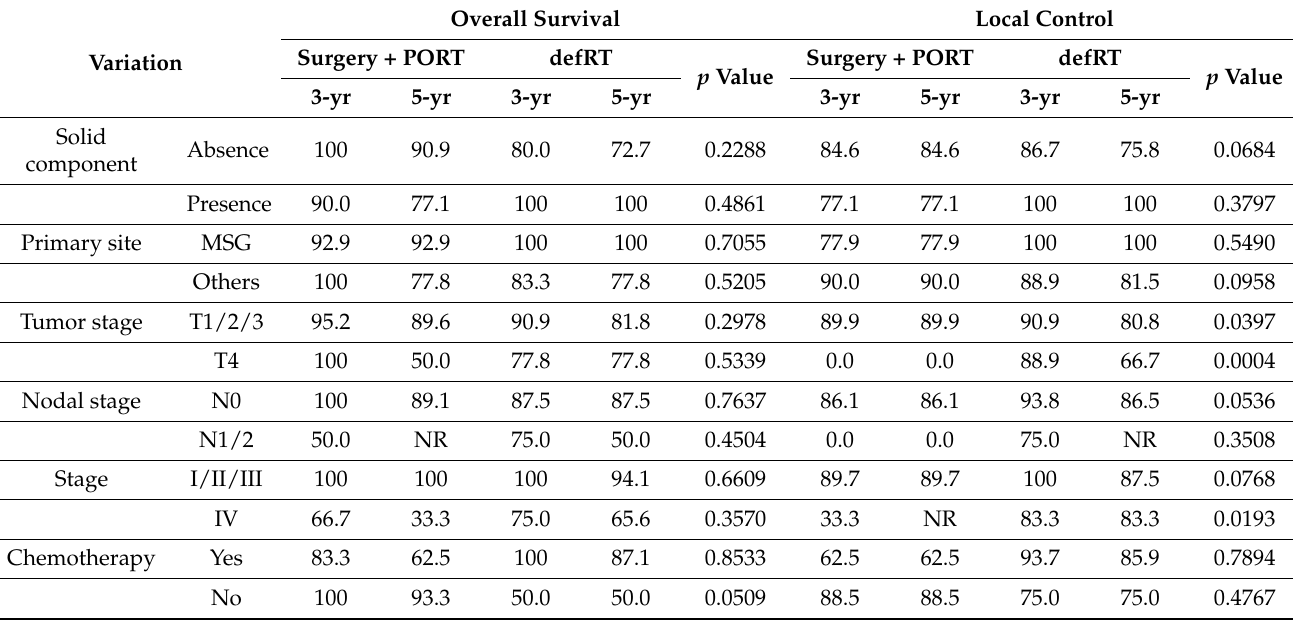
Table 3. Comparison of overall survival and local control rates by treatment modality in patients with clinical